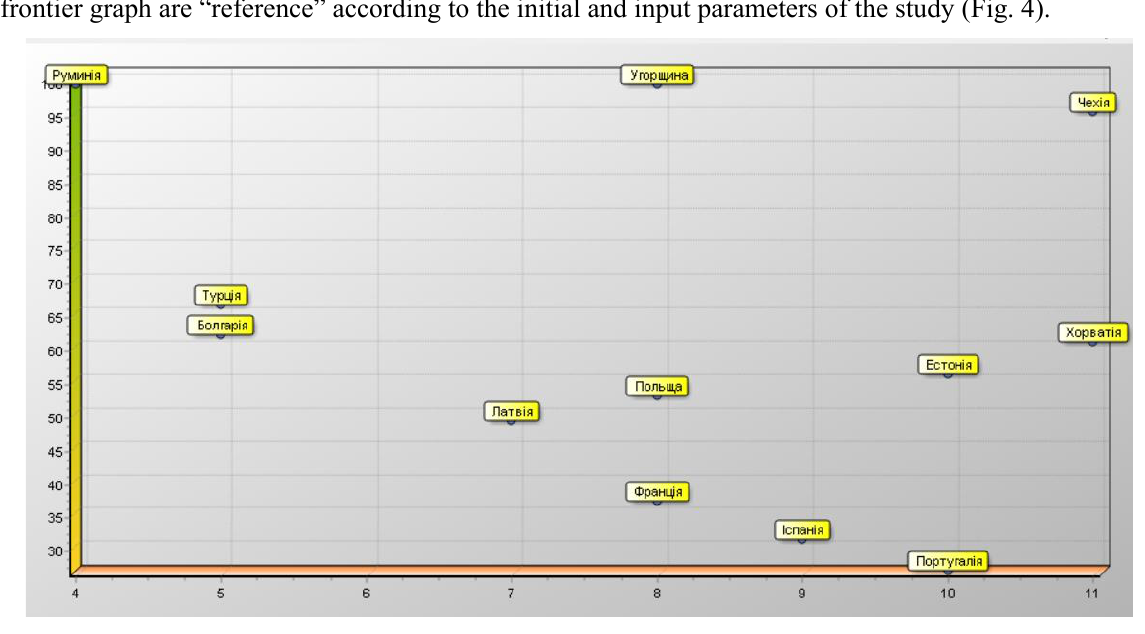
Figure 4. Graph of countries’ efficiency (for the 1 st group of the 2 nd cluster)